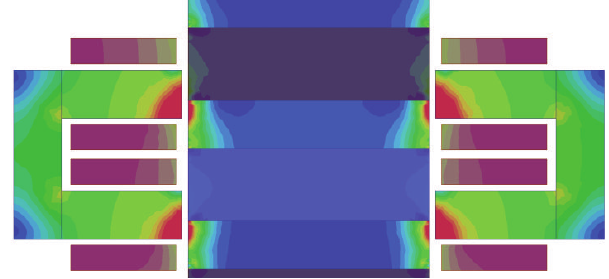
Figure 27: Magnetic flux density at 𝑡 = 30 ms.